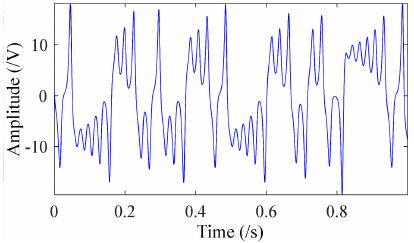
Figure 6. Time domain plot of Lorenz without noise.